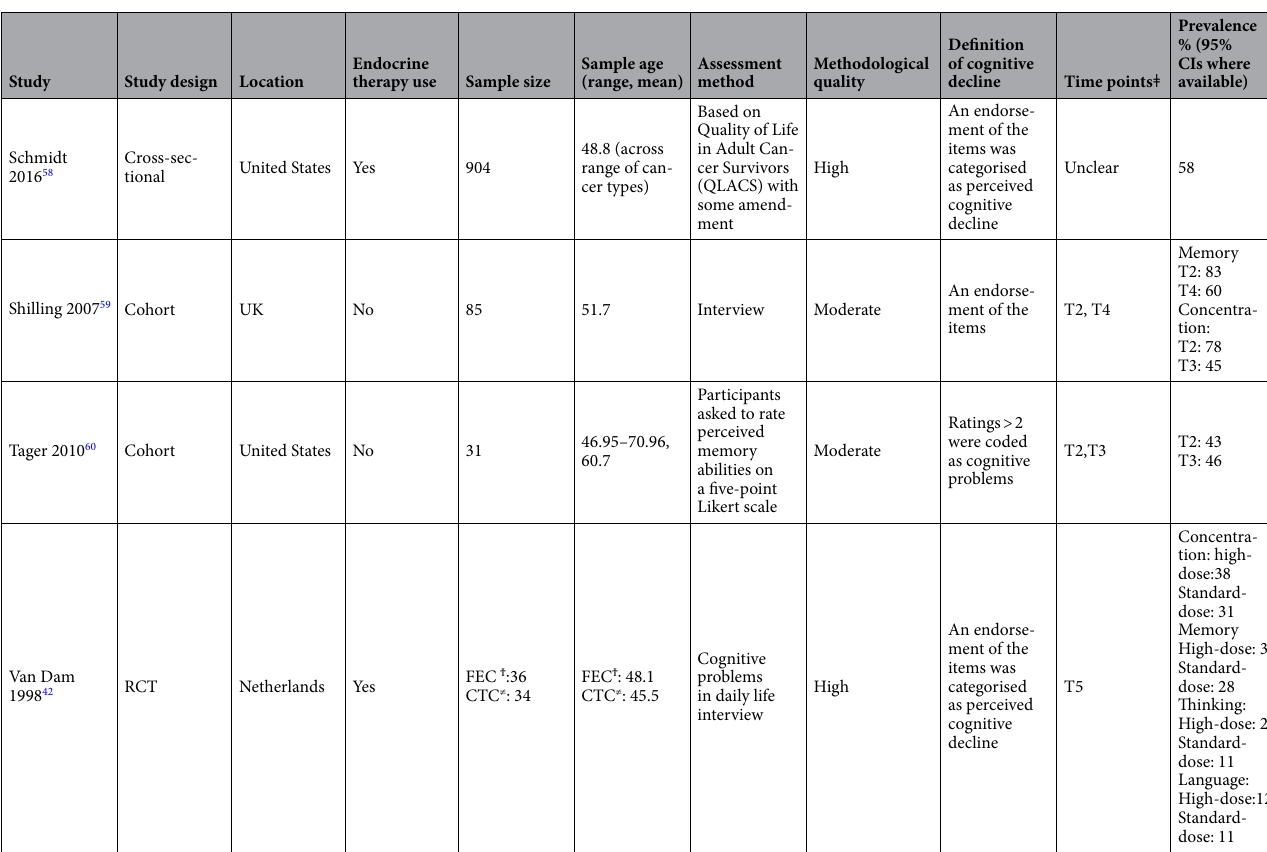
Table 1. Summary of included studies that used self-report measures of cognitive impairment. *Time-points measured in study cross time-points used in this review preventing accurate assimilation. ǂ T1 = During chemotherapy treatment, T2 = Just after cessation of treatment, T3 = 6 months after treatment cessation, T4 = 1 year after treatment cessation, T5 = 2–3 years after treatment cessation, T6 = 5–10 years after